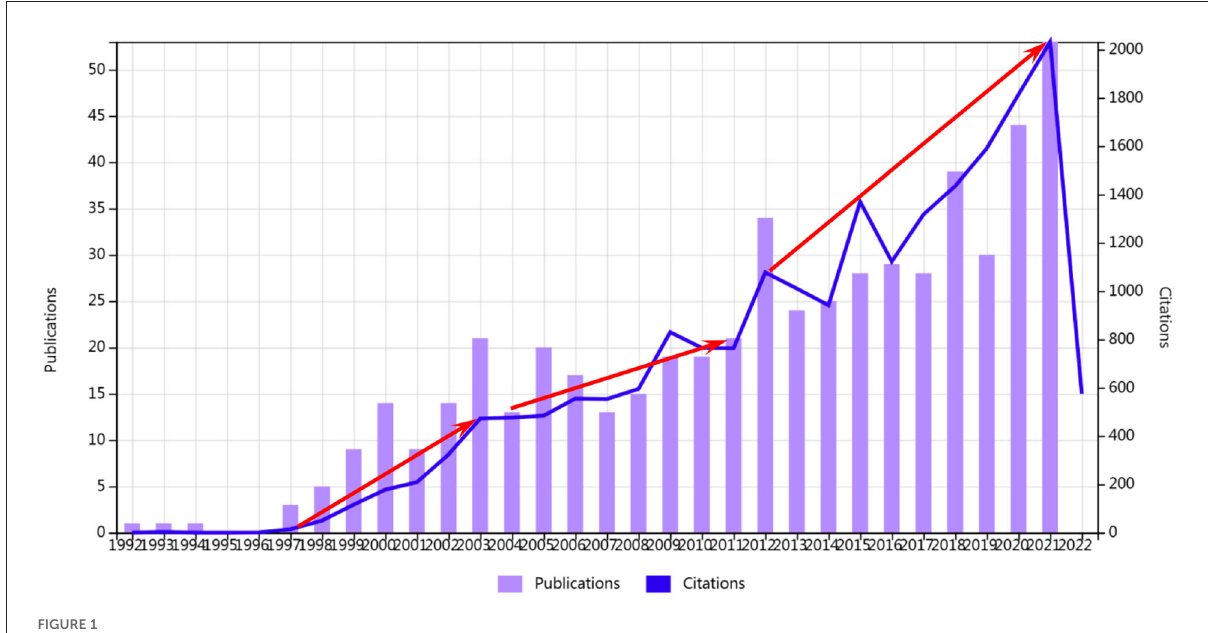
FIGURE1 Times cited and publications over